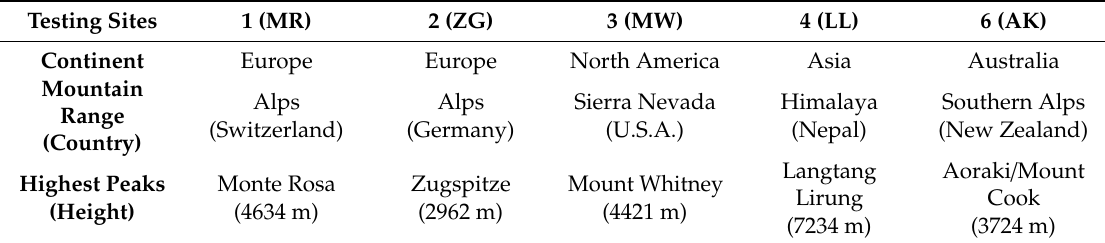
Table 1. Attributes of the five selected study areas including Monte Rosa (MR), Zugspitze (ZG), Mount Whitney (MW), Landtang Lirung (LL), and Aoraki (AK) with their location, mountain range, country, and the highest peak. 1 (MR) 2 (ZG) 3 (MW) 4